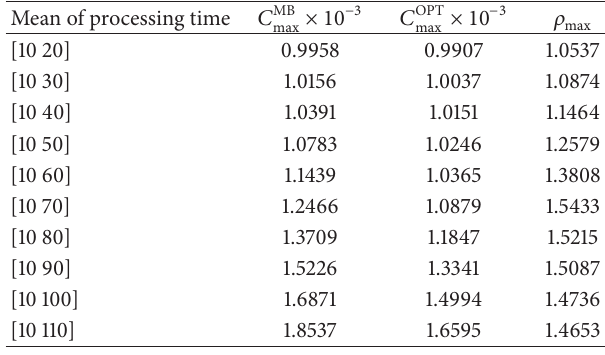
Table 5: The performance of the proposed algorithm (MB) against OPT where the number of jobs is 25.